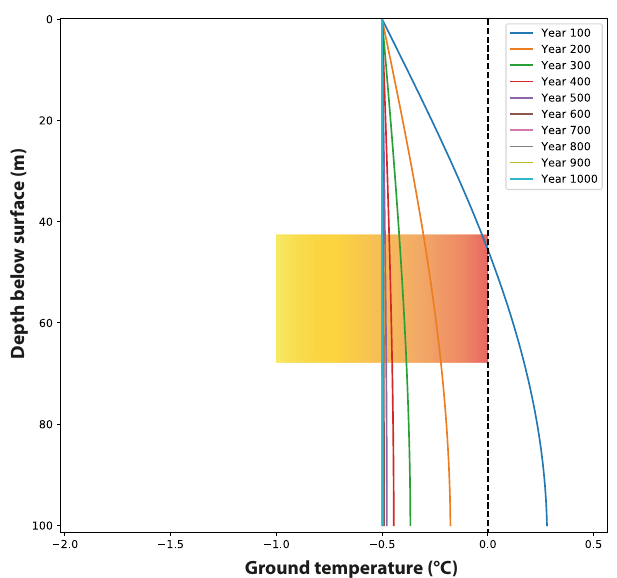
Fig. 4 Scenario 3 simulating the impact of winter snow cover on the stability of the permafrost. This model uses the temperature pro fi le at the end of a 200 yr-long interstadial (Fig. 3), a mean annual air temperature of − 2 °C and a Δ T of 6 °C. The curves depict the mean annual temperature. The rectangle with the orange shading marks the − 1 to 0 °C window of the possible formation of cryogenic cave carbonates for the depth range of the Obir